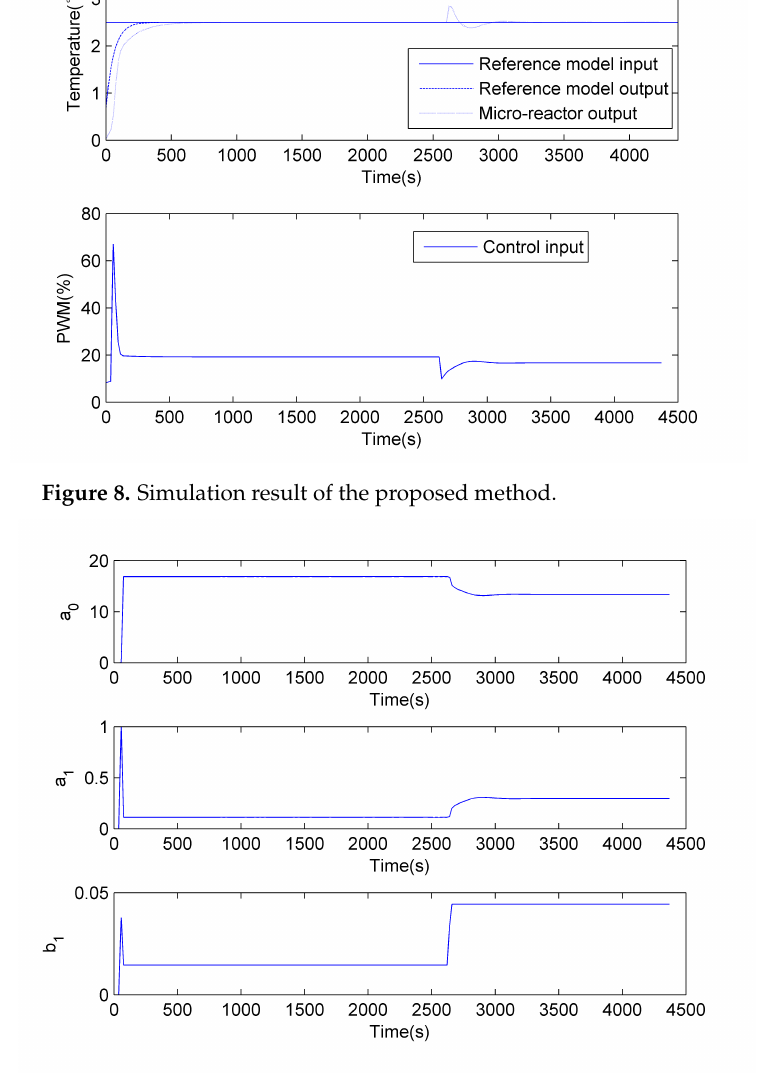
Figure 9. Parameter estimation of the proposed